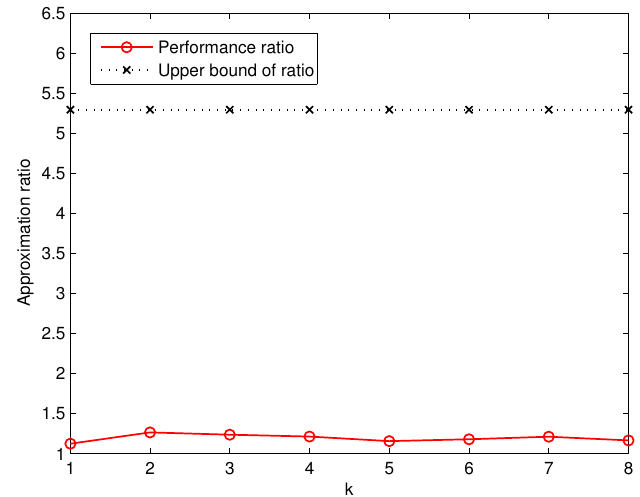
Figure 8. Measured average approximation ratio of GreedyDLDT for DLDT in response to varying k